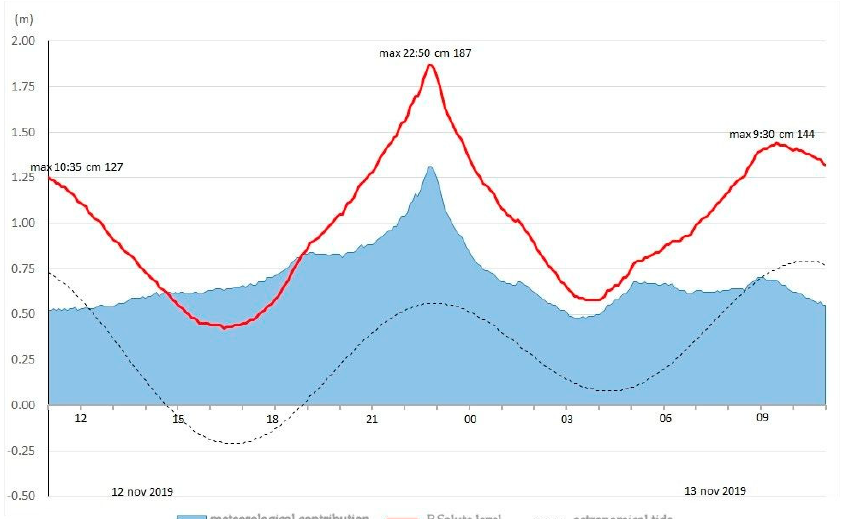
Figure 7. Sea level (red line), storm surge (cyan filled profile), and astronomical tide (dashed line) at “Punta Salute” station, on12–13 November 2019.The sea level peak in Venice, measured at Punta Salute tide station, on the side of the Giudecca canal, was 189 cm, the second highest since 1872, the year in which data collection began. Time is expressed in UTC+1.